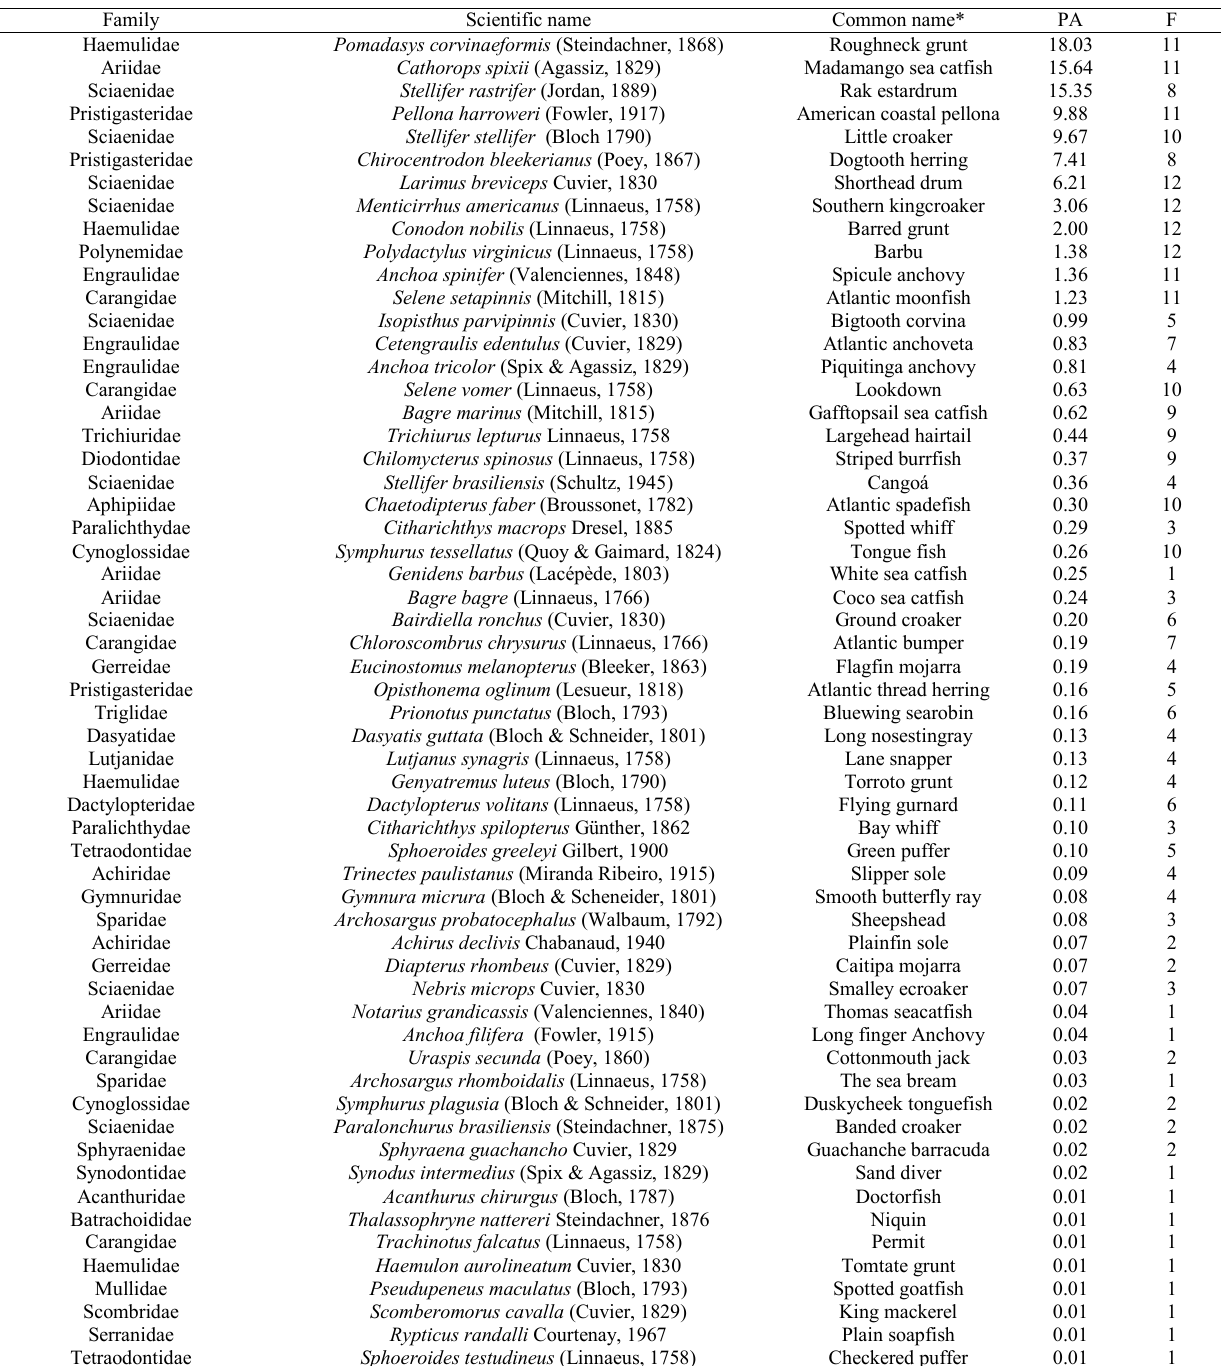
Table 2. Bycatch species at the São Cristóvão beach, with the respective common names, families, percentage abundance (%) and frequency (in months). Legend: * All common names were obtained from Fishbase; PA - Percentage Abundance; F -